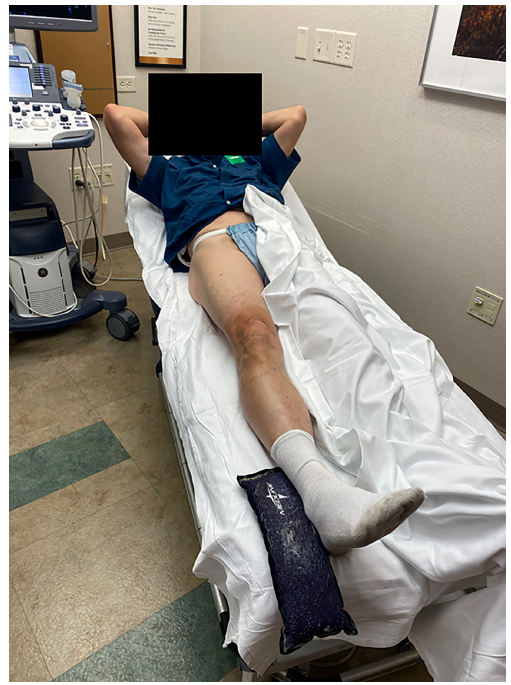
Figure 1. Patient